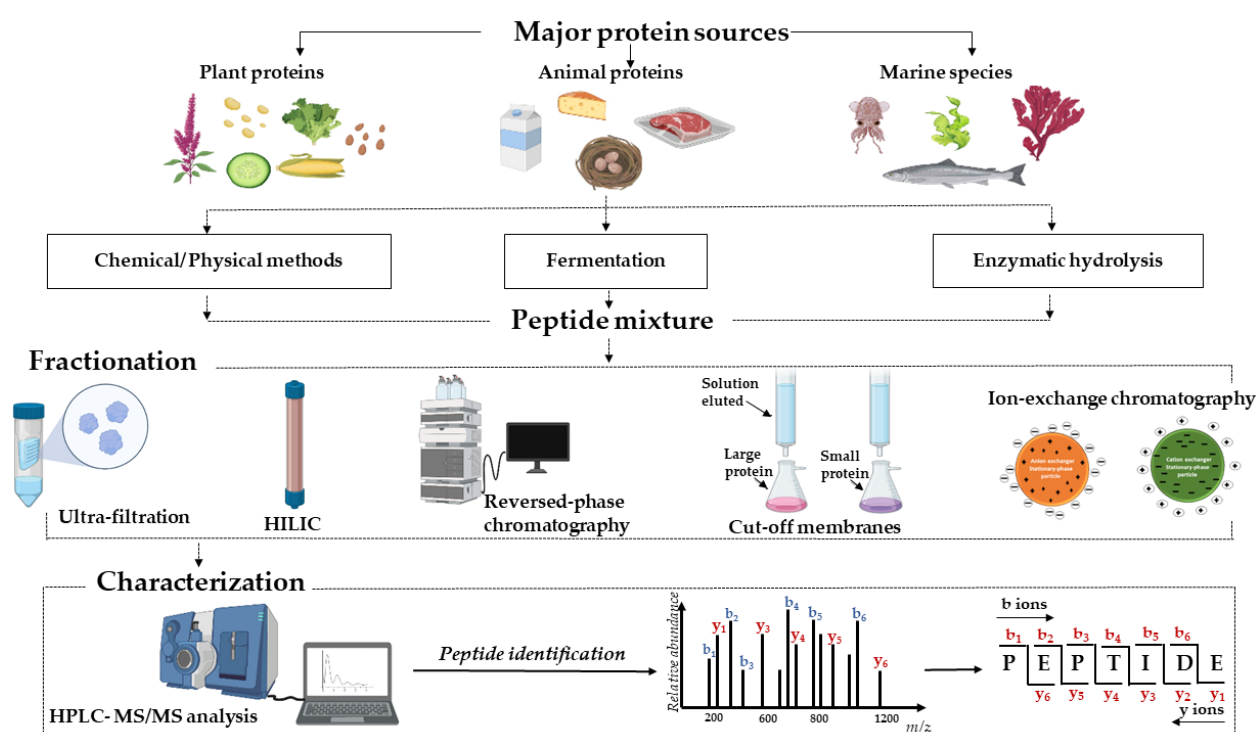
Figure 1. Workflow for identifying peptide sequences from dietary protein sources.